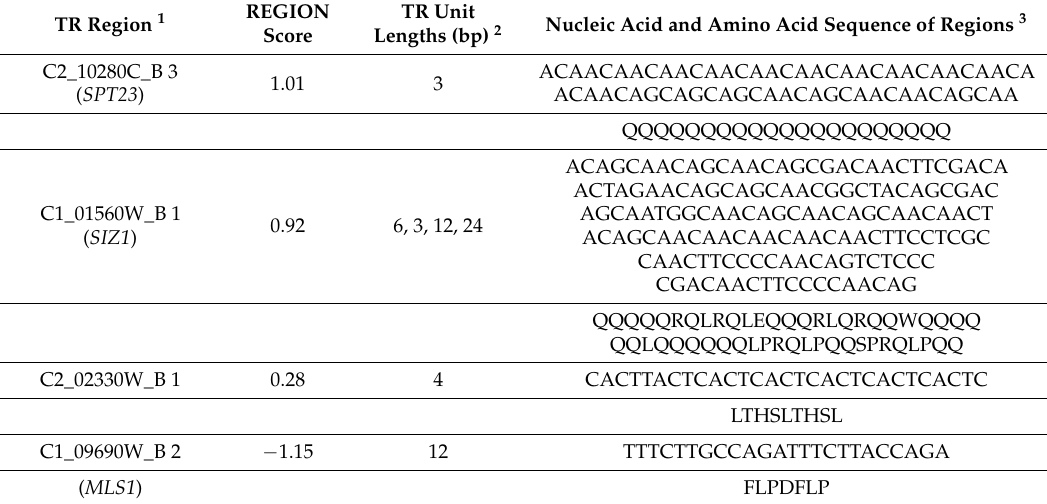
Table 1. Examples of TR